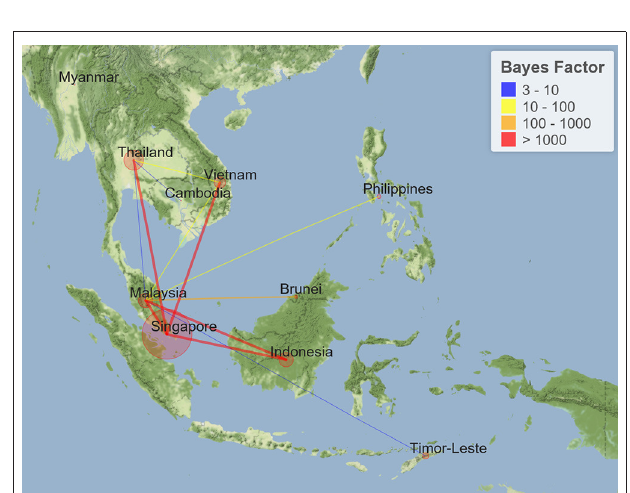
FIGURE 3 | Transmission links of coronavirus disease 2019 (COVID-19) within Southeast Asia tested by Bayes factor (BF). Line colors represent the relative strength by which the rates are supported: very strong (BF > 1,000, red lines), strong (100 < BF < 1,000, orange lines), moderate (10 < BF < 100, yellow lines), and positive (3 < BF < 10, blue lines).